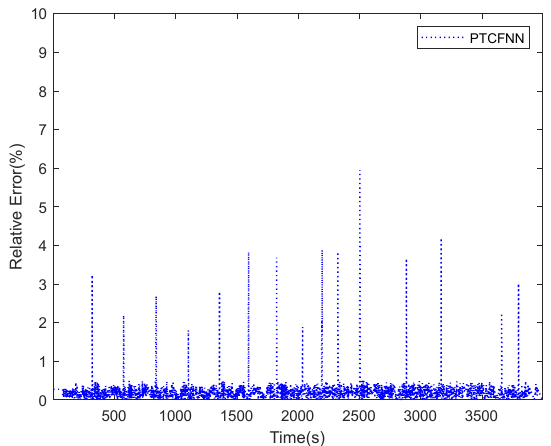
Figure 17. SOC estimation during dynamic current with disturbance.